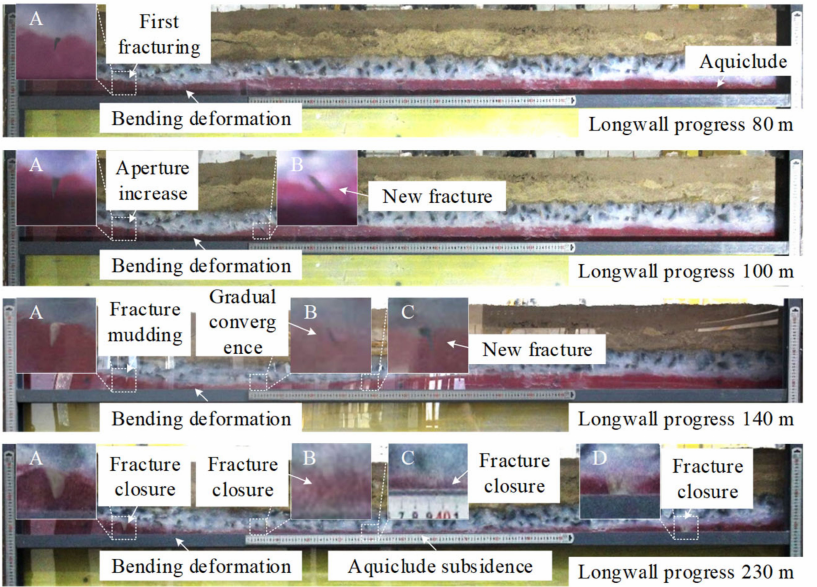
Figure 4. Variation of aquiclude fracture initiation, propagation, and